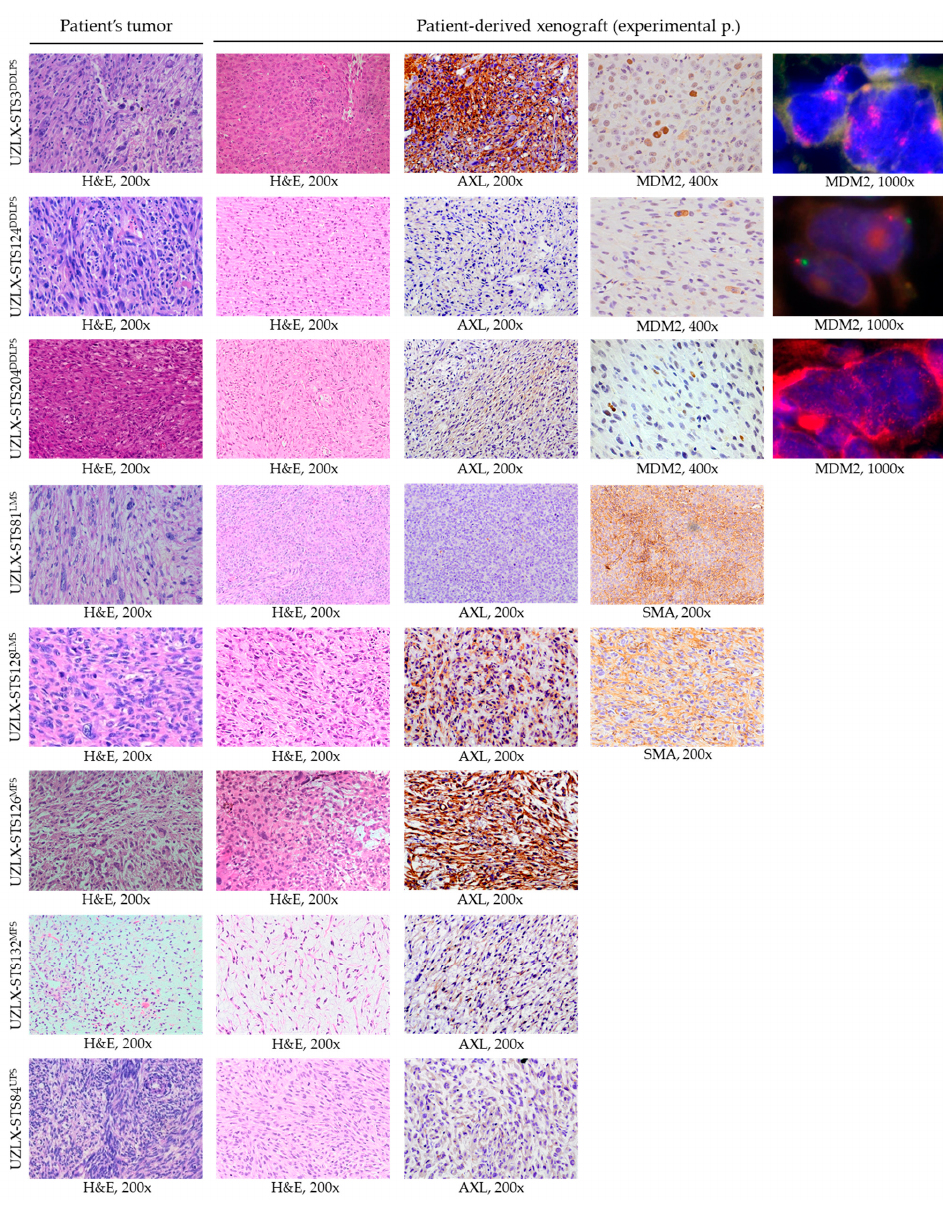
Figure 2. Characterization of the patient-derived sarcoma xenograft models used in this study. Representative images of H&E, immunostainings and FISH of the original patient tumors and the corresponding patient-derived xenografts. alpha-SMA: alpha smooth muscle actin; H&E: hematoxylin & eosin; MDM2: mouse double minute 2 homolog; p.: passage; 200×: 200-fold magnification; 400×: 400-fold magnification; 1000×: 1000-fold magnification.